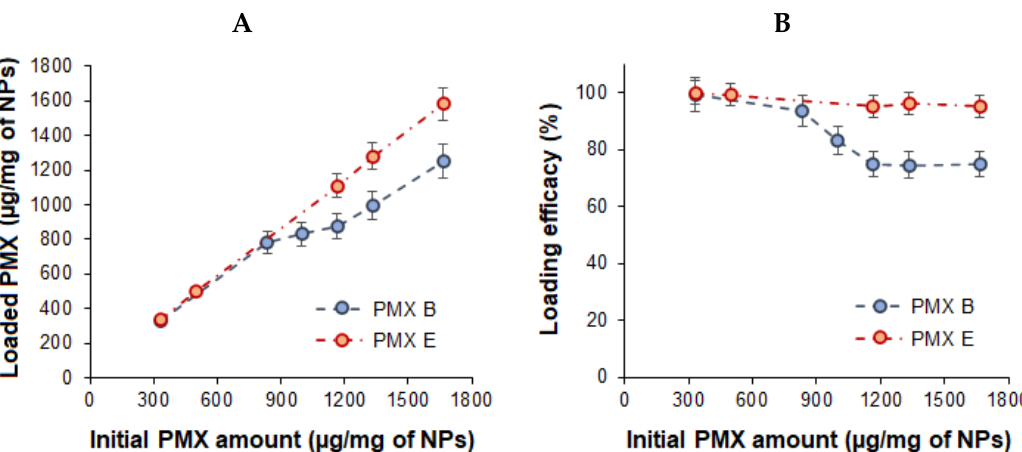
Figure 8. Drug loading (DL) ( A ) and loading efficacy (LE) ( B ) for polymyxins B and E loaded into hybrid nanoparticles.